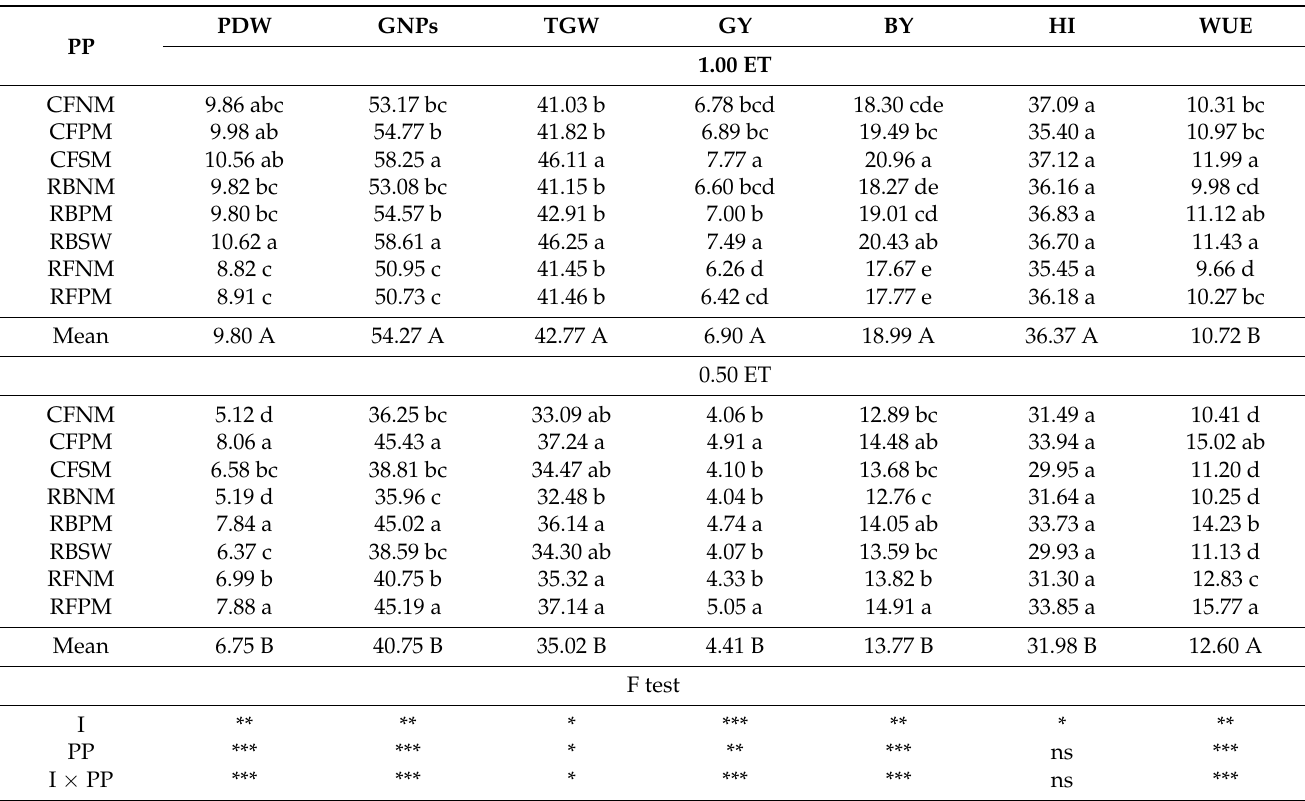
Table 2. Plant dry weight (PDW), grain number spike–1 (GNPS), 1000-grain weight (TGW), grain yield (GY), biological yield (BY), harvest index (HI), and water use efficiency (WUE), as affected by different combination of planting patterns (PP) and mulching under full (1.00 ET) and limited (0.50 ET) irrigation rate (I), and as main effects for the second